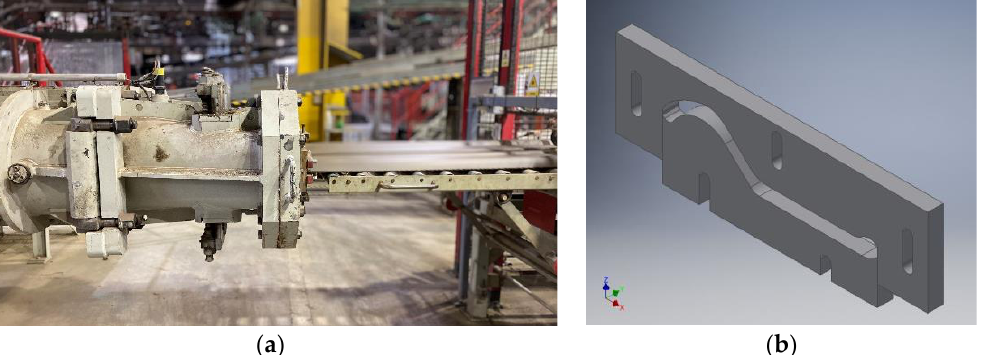
Figure 2. Process of forming a clay strand: ( a ) extruding the strand on a pug mill, ( b ) a 3D model of the tool shaping the strand (bit ) .